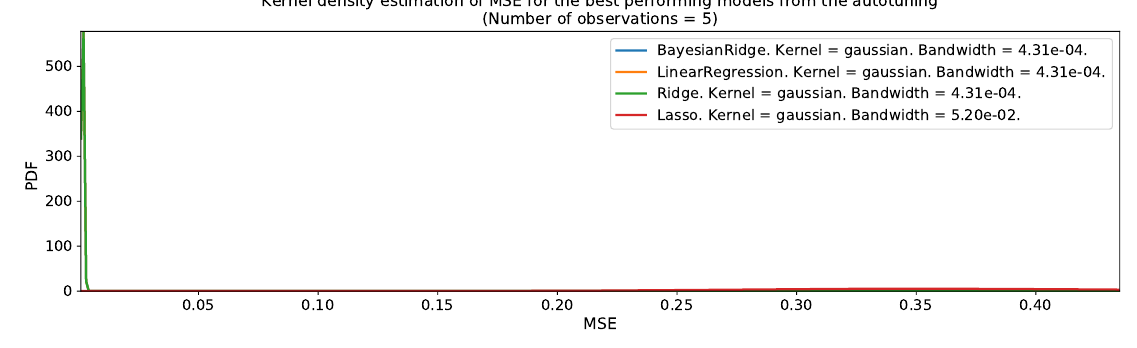
Figure 22. Estimated probability density functions of the mean square error in the spatiotemporal regression of the population distribution for different families of models as returned by the autotuning program in